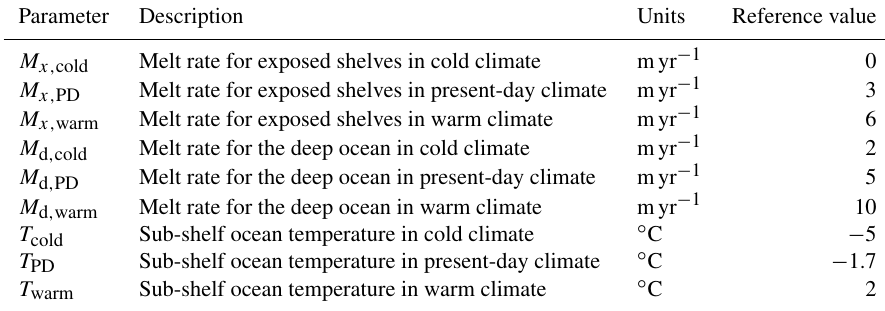
Table 3. Reference values for the uniform melt rates for exposed shelves M x and the deep ocean M d and for the sub-shelf ocean temperature T .